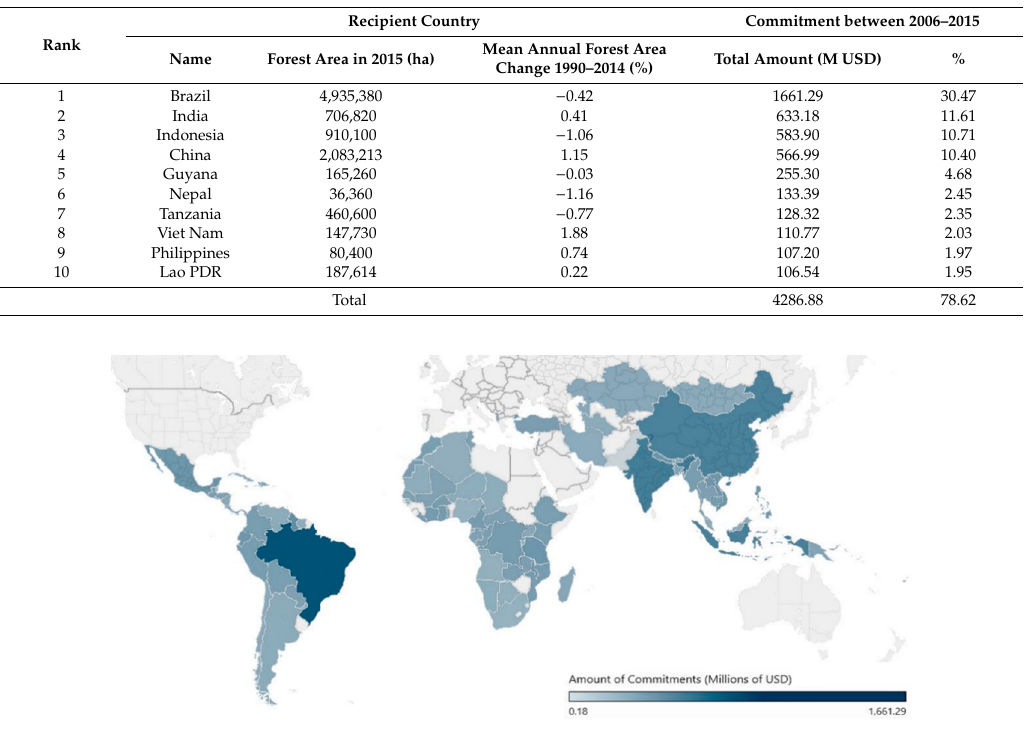
Table 5. The amount of financing commitment received and the associated ranking of the recipient countries, with forest status (2006–2015).